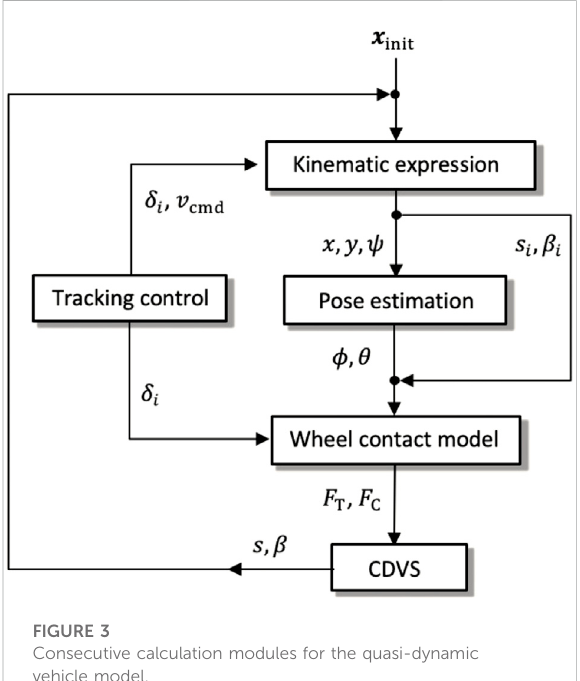
FIGURE 3 Consecutive calculation modules for the quasi-dynamic vehicle model.